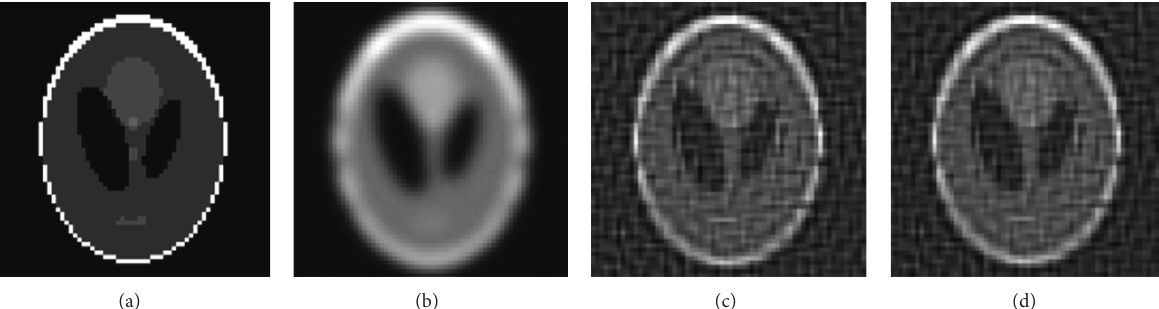
Figure 3: (a) True image, (b) blurred and noisy image, (c) restored image with LSQR, Iter = 104, and REN = 0.5004, and (d) restored image with LSMR, Iter = 128, and REN = 0.4919.